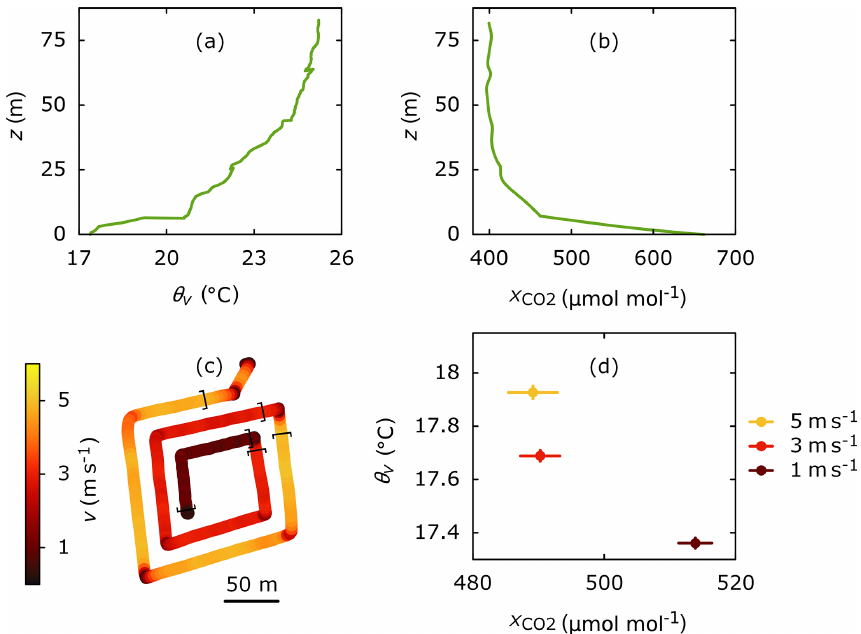
Figure 10. Vertical profiles of (a) virtual potential temperature θ v and (b) CO 2 dry-air mole fraction x CO (c) Track of flight at 22:15UTC on the same night coloured by horizontal ground speed. Three sections of nominal speeds of 5, 3 and 1ms − 1 are marked with brackets. Height was 10m above ground throughout the flight. (d) Median of virtual potential temperature and CO 2 dry-air mole fraction measured during those three sections of the flight. Bars represent the bootstrapped standard error of the median; see text for details. The standard error of the virtual potential temperature is so small that the vertical bars are barely visible. At lower speeds, θ v is lower and x CO is higher, suggesting the sampling of air that originates from below the flight 2